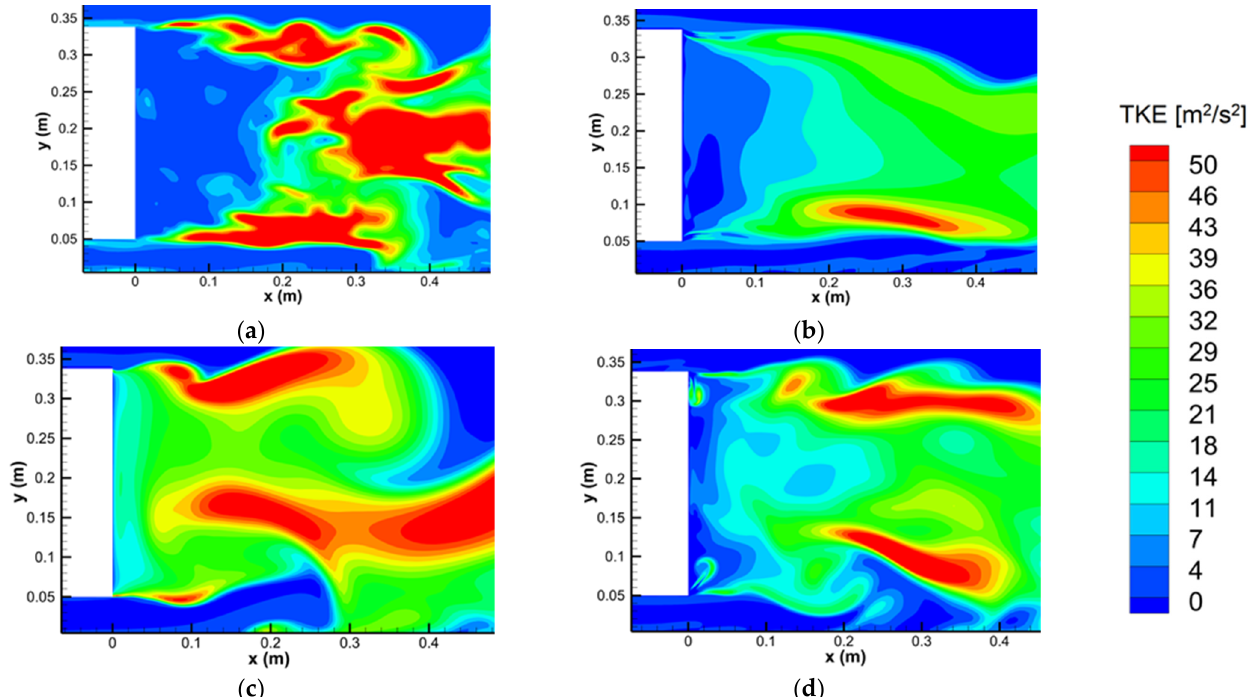
Figure 13. Contour of TKE behind of model, on the symmetry plane with different actuator types. ( a ) Baseline flow; ( b ) a steady blowing jet; ( c ) a synthetic jet; ( d ) an unsteady jet.